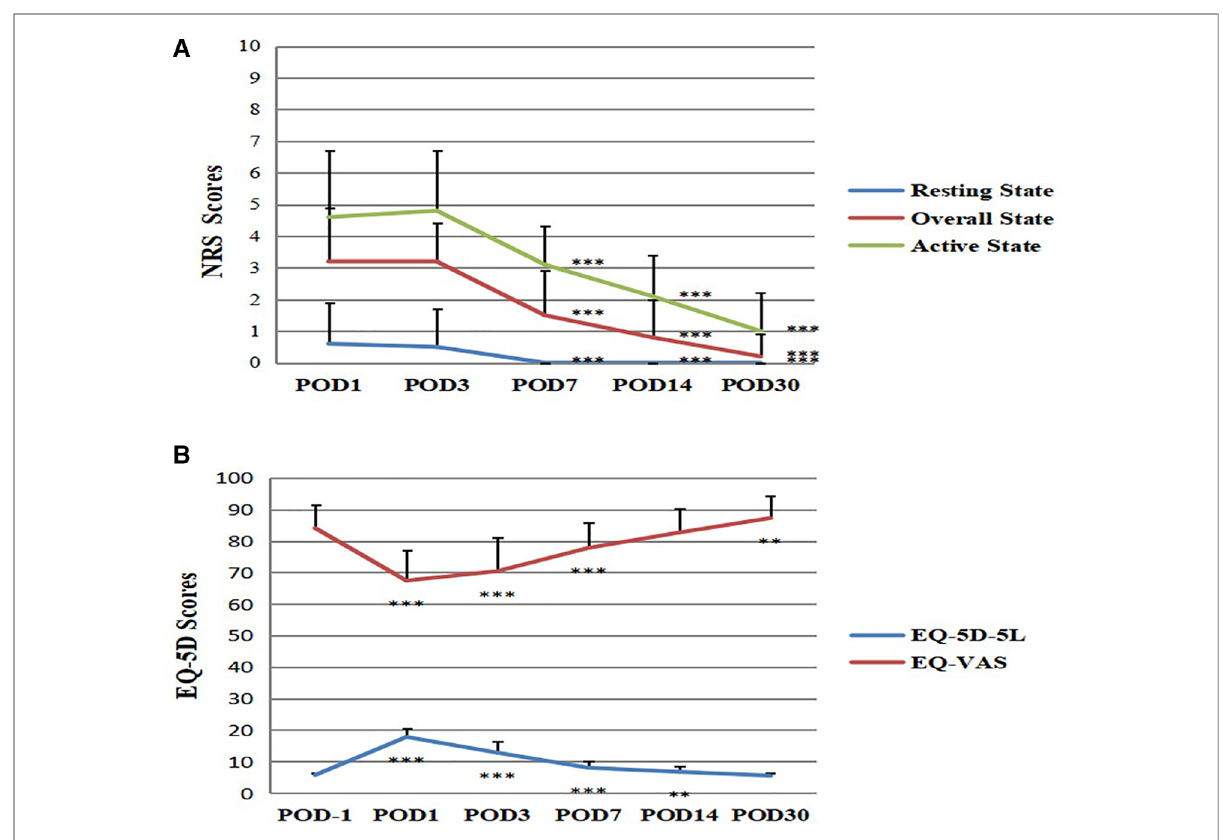
FIGURE 2 Changes of NRS and EQ-5D scores after surgery. ( A ) Changes of NRS scores after surgery. Compared with POD1, *** P <0.001, the difference was statistically signi fi cant. ( B ) Changes of EQ-5D scores after surgery. Compared with POD-1, ** P <0.01, *** P <0.001, the difference was statistically signi fi cant. POD=Postoperative Day.